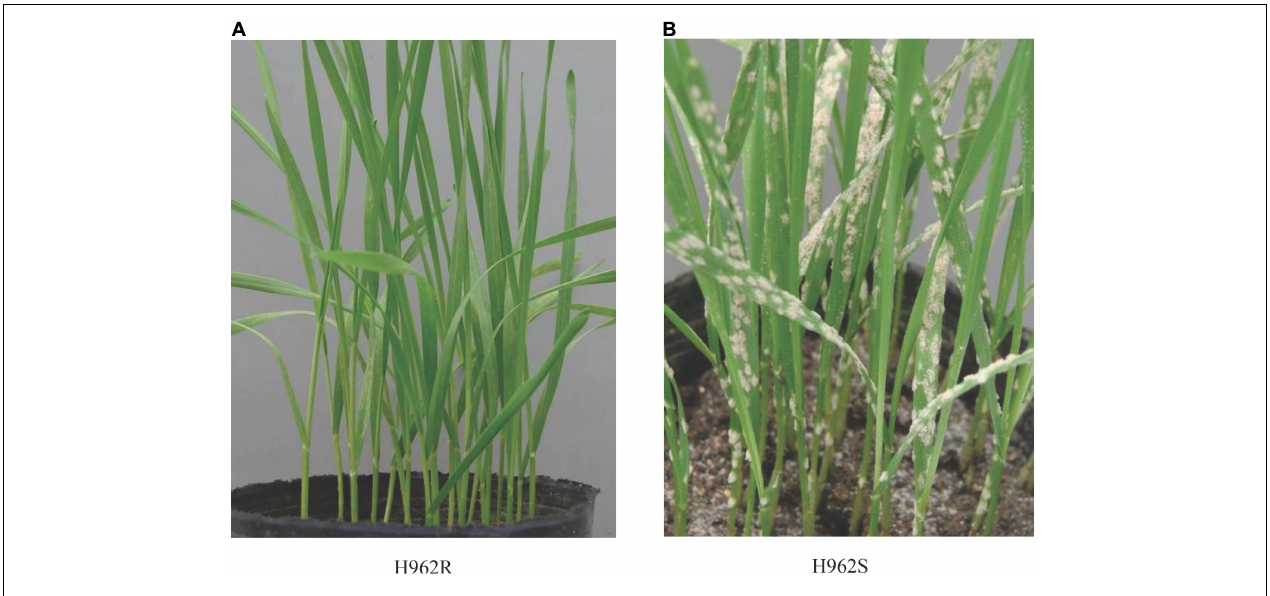
FIGURE 3 | Seedling phenotypes of H962R (A) and H962S (B) to Blumeria graminis f. sp. tritici isolate A49. TABLE 1 | Inheritance analysis of lines H962R and H962S and their F 1 , F 2 , F 2 : 3 , and F 2 : 9 progenies for resistance to Blumeria graminis f. sp. tritici isolate E09. Parents or cross Generation a Total number of plants/families Observed ratio Expected